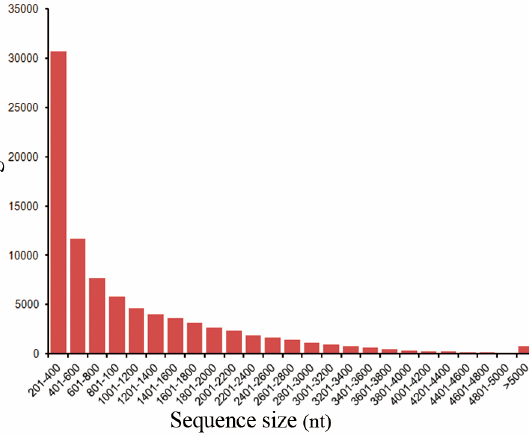
Figure 1. Length distribution of unigenes identified in our de novo assembly Total number (87,137), Total length (91,915,266 bp), Mean length (1054.84 bp), Maximum length (15,111 bp), Minimum length (201 bp), N50 length (1796 bp), N90 length (425 bp), Number of unigenes with >N50 (16,181).